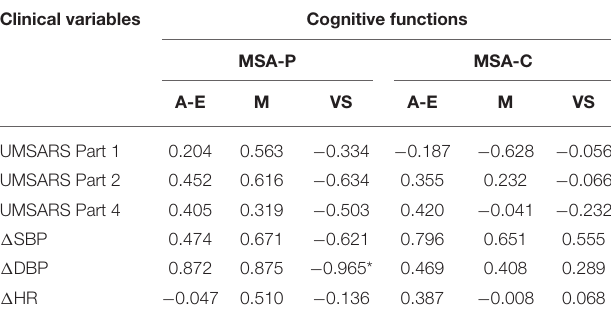
TABLE 4 | Partial correlations between clinical variables and scores obtained at neuropsychological tests (divided by cognitive function). Clinical